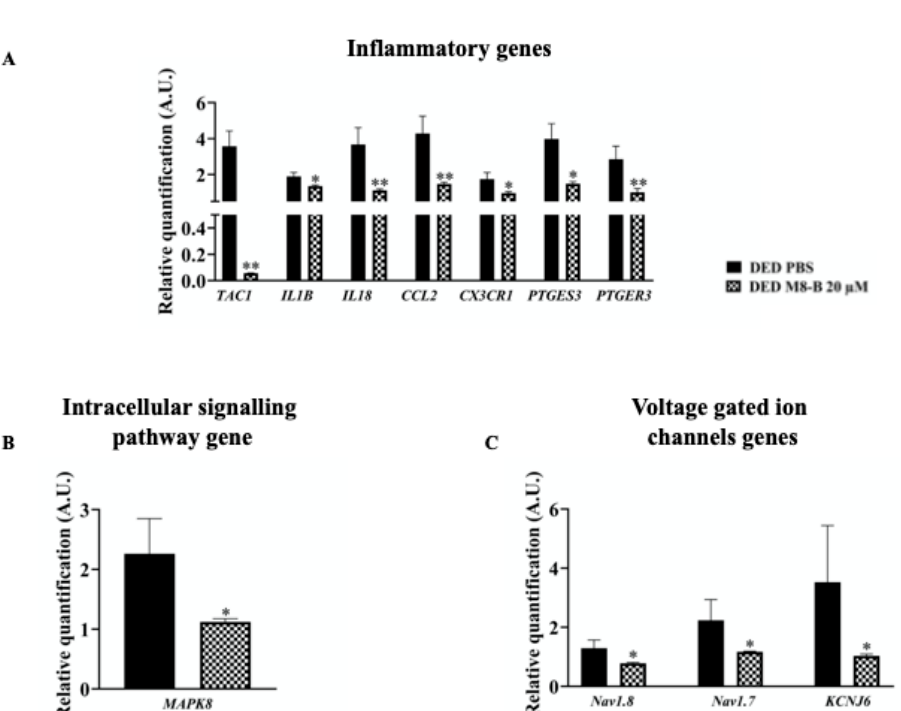
Figure 6. Evaluation of the expression of genes implicated in conduction and modulation of pain responses in TGs of DED mice treated with 20 µM M8-B vs. PBS. ( A – C ) RT-qPCR analysis of ipsilateral TGs of DED mice treated with 20 µM M-8B vs. PBS at day 21. DED mice treated with 20 µM M8-B vs. PBS ( n = 4–5). * p < 0.05 and ** p < 0.01 relative to DED mice treated with PBS. Results are expressed